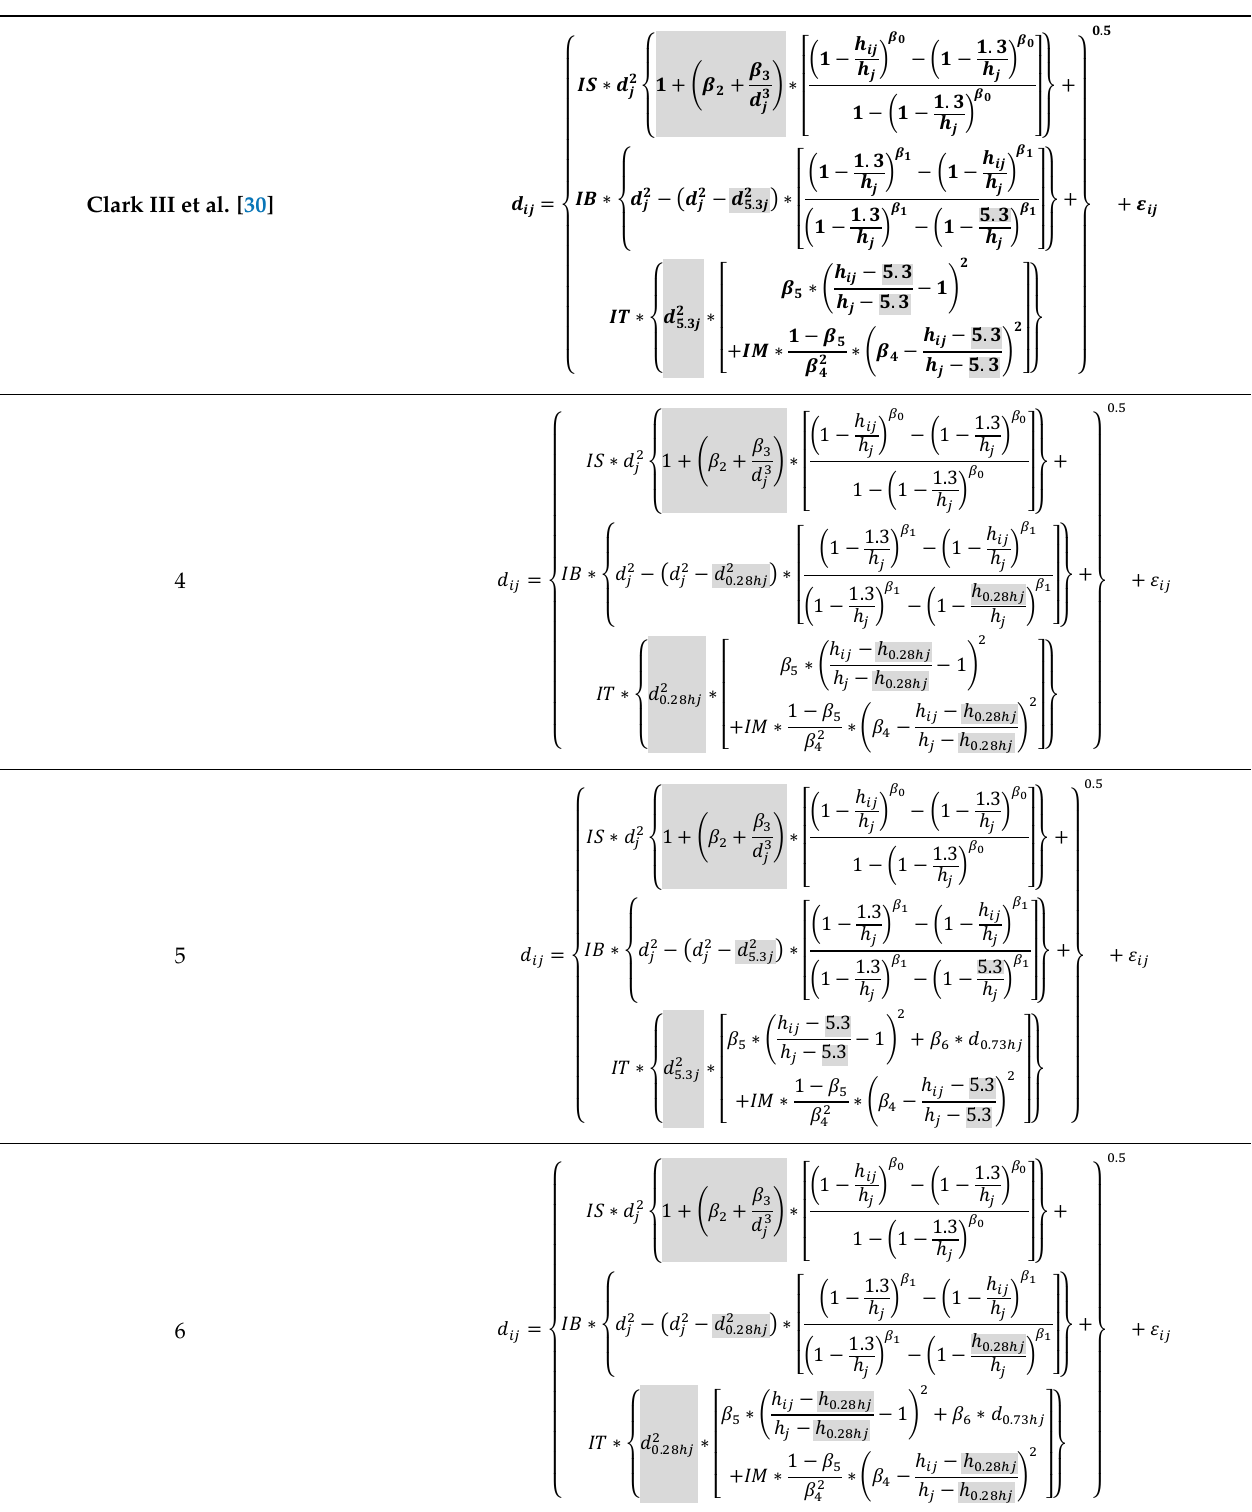
Table 4. Modifications proposed to the Clark III et al. model for the adjustment of data from Tectona grandis L.f., central-west region, Brazil Table 4. Cont.